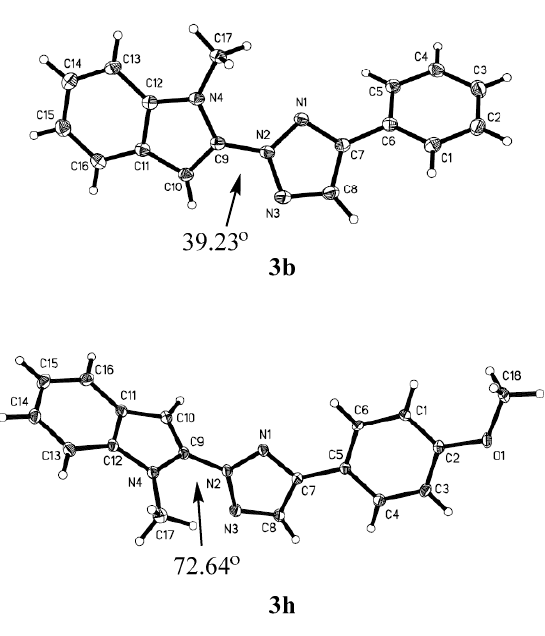
Figure 3. X-ray crystal structures of 3b and 3h.